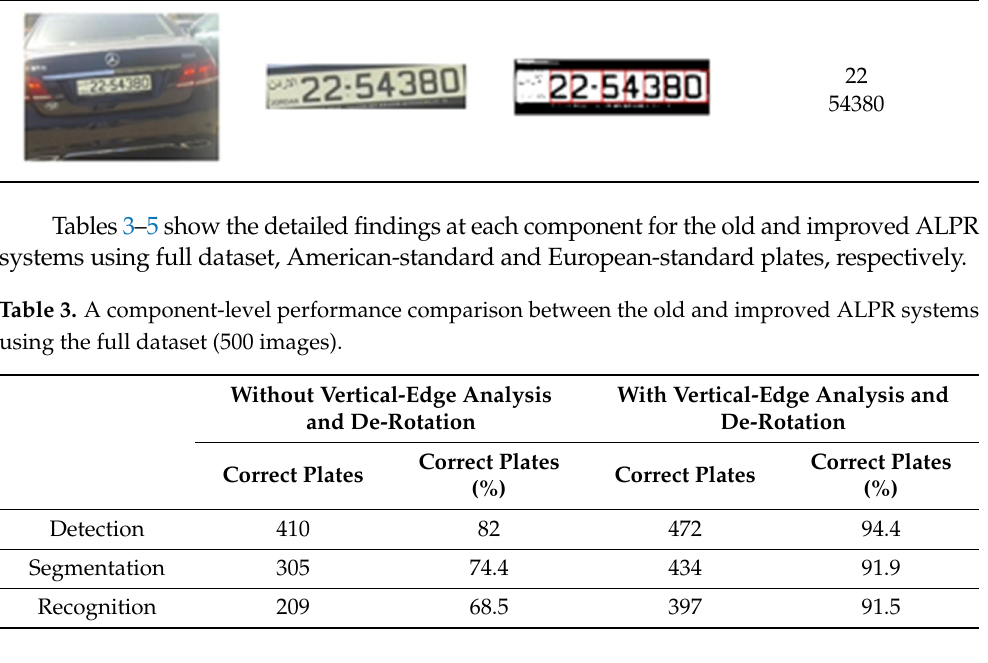
Table 4. A component-level performance comparison between the old and improved ALPR systems using the American-standard plates (500 images).